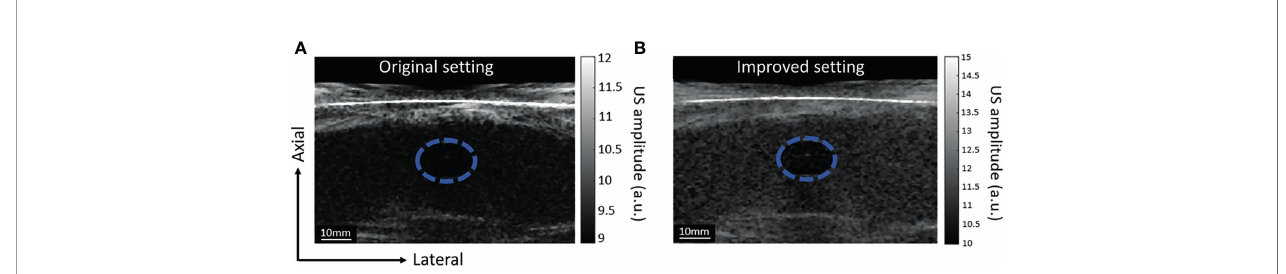
FIGURE 4 | Grayscale US images of the phantom with inclusion, images acquired with two different settings. The blue-dashed circle highlights the location of the inclusion. The difference in corn starch concentration generates contraction in US images. (A) US image acquired with the DSM-1 setting: 5 incident angles and US acquisition voltage of 1.6 V. (B) US image acquired with the DSM-2 setting: 9 incident angles and US acquisition voltage setting of 10 V.